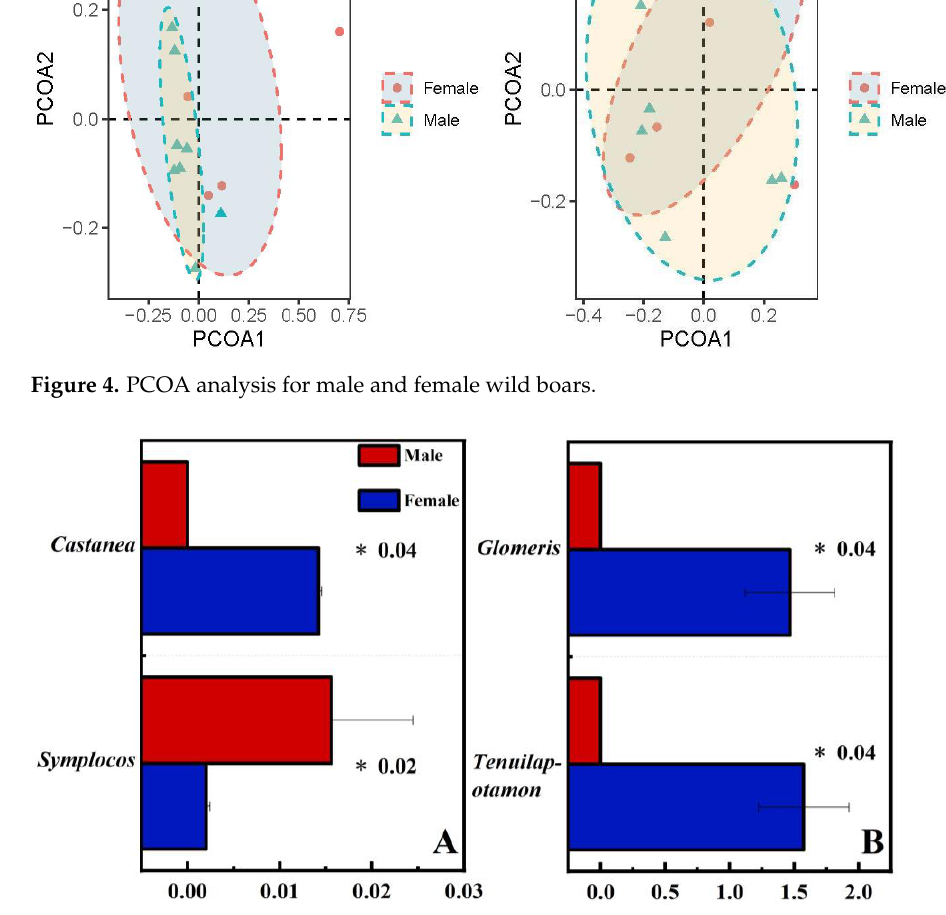
Figure 5. Comparison of relative abundances at the genus levels between male and female wild boars regarding ( A ) plant food sources and ( B ) animal food sources. * represents a significant difference p <